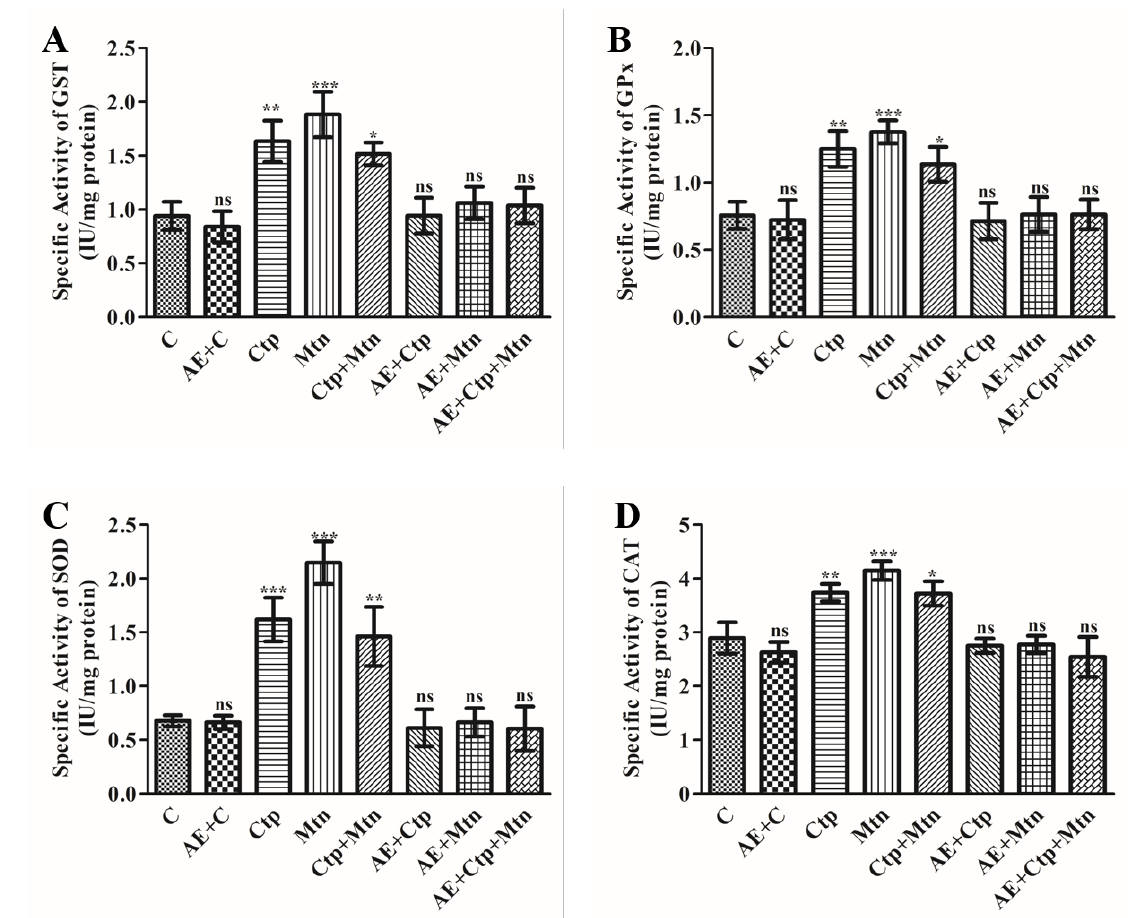
Figure 2. Effect of cartap, malathion and aqueous extract of A. vera leaves on the levels of antioxidative enzymes rat blood serum. The activity of enzymes ( A ) GST, ( B ) GPx, ( C ) SOD, and ( D ) CAT were determined in the rat blood serum as mentioned in Materials and methods. The unit of enzyme activity was expressed as IU mg −1 protein. The data represent mean ±SD of 3 independent experiments. The values were significant at p < 0.05 as compared to control group.